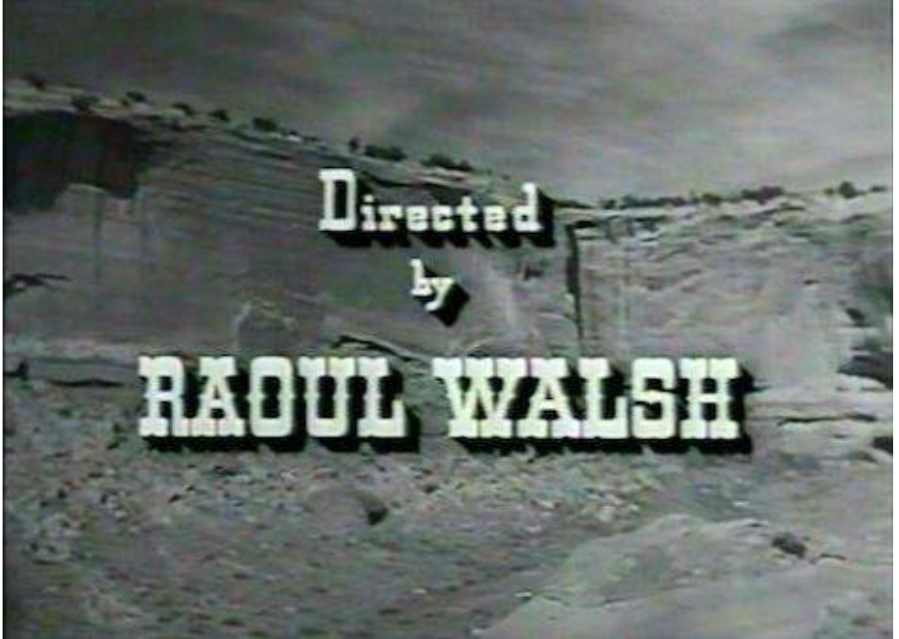
Figure 9: The Wild-West barren landscape at the start of Colorado Territory